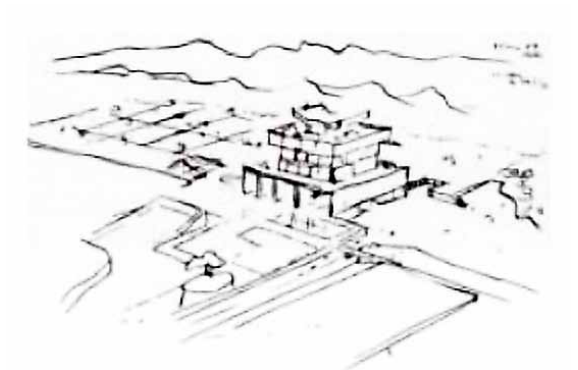
fig. 15. Corbusier’s vision of the Governor Plaza in his sketch including the plaza which is “shifted” and recalls a pinwheel form. The heightened curved structure crowning the palace seem to recall the elevated yet “inverted” forms of the chattri (Von Moos